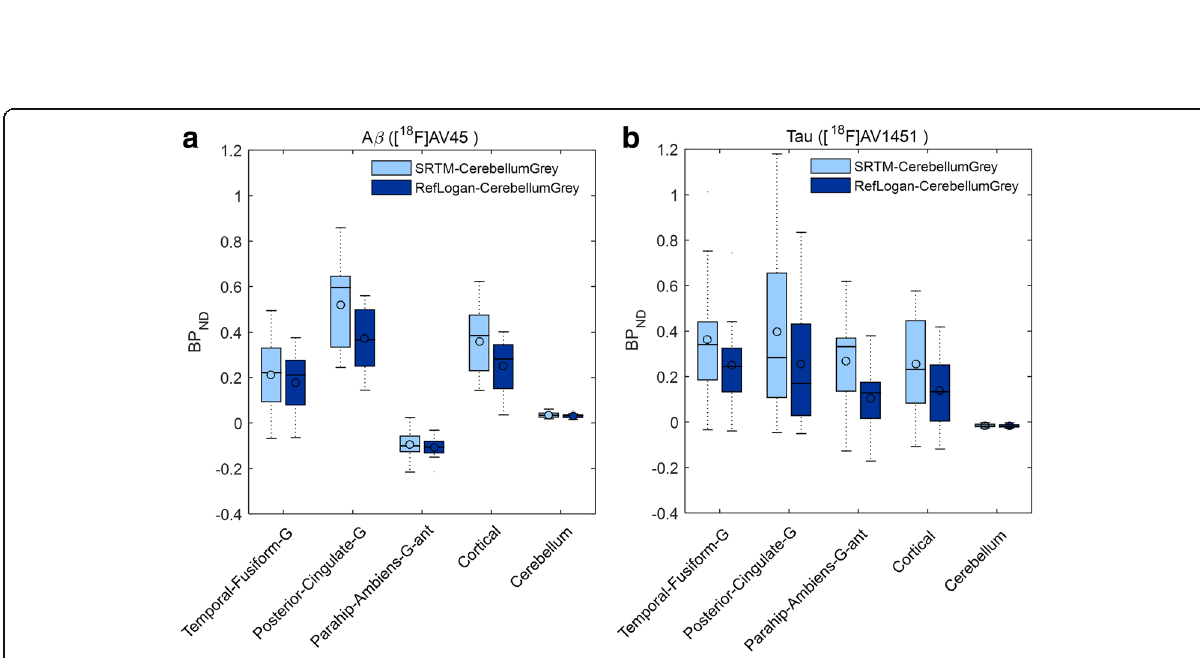
Fig. 3 Estimated regional BP ND values using SRTM and reference Logan graphical analysis with cerebellum grey as reference region across all subjects for selected regions for A β ( a ) and tau ( b ) dynamic PET scans. The BP ND values estimated by reference Logan graphical analysis are for optimum t * values ( t * = 20 for A β and t * = 50 for